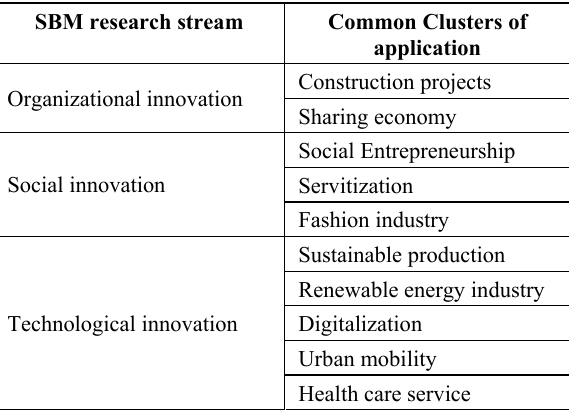
Table 2. The SBM most common clusters of application classified according the SBM research